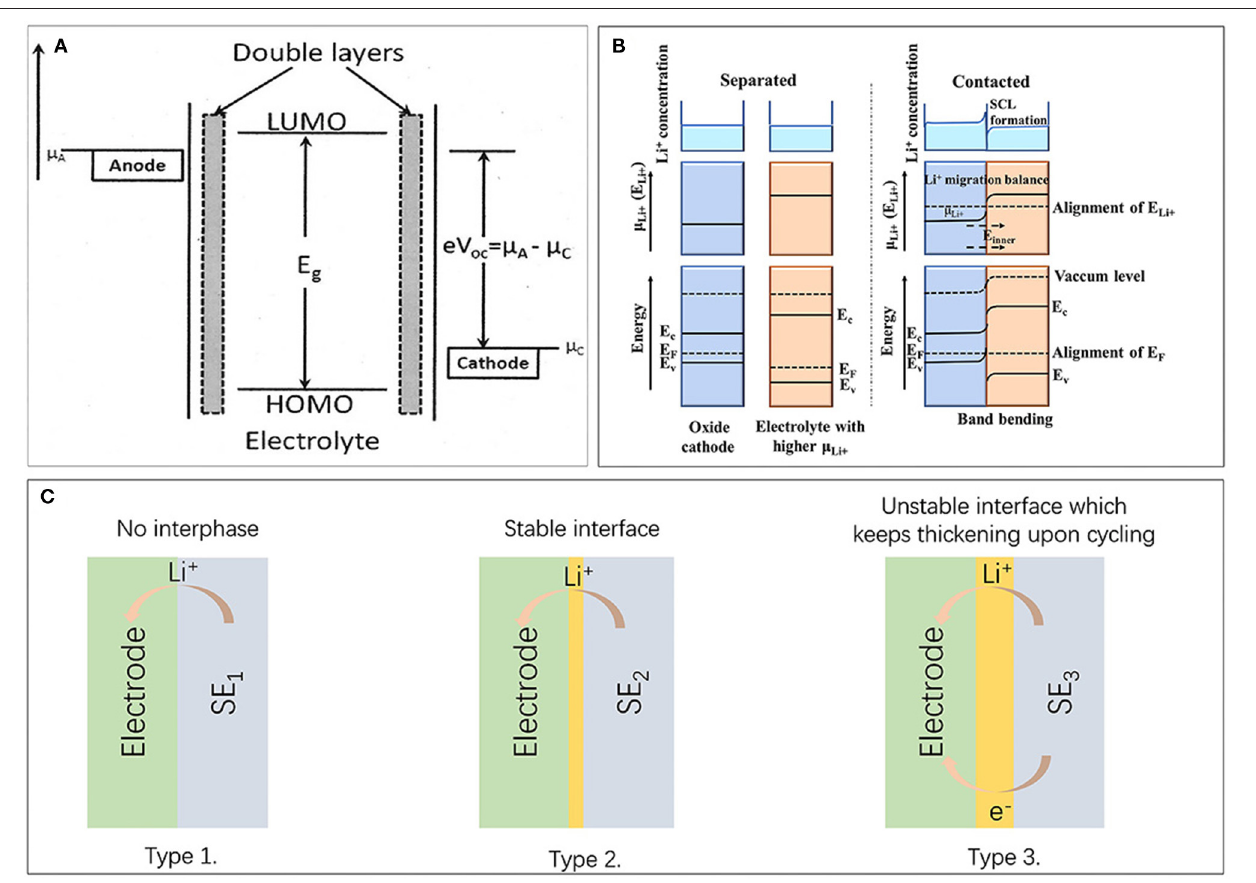
FIGURE 1 | (A) Relative energies of µ A and µ C vs. the LUMO-HOMO window of the electrolyte. [Reprinted with permission from Goodenough (2013). Copyright (2013) American Chemical Society]. (B) Illustration of ionic and electronic structures of electrode and electrolyte before (left) and after contact (right). Shown is a mixed ionic and electronic conducting electrode in contact with a pure ionic conducting solid electrolyte with higher Li + chemical potential. (C) Illustration of three possible types of the solid electrolyte/solid electrode interfaces.